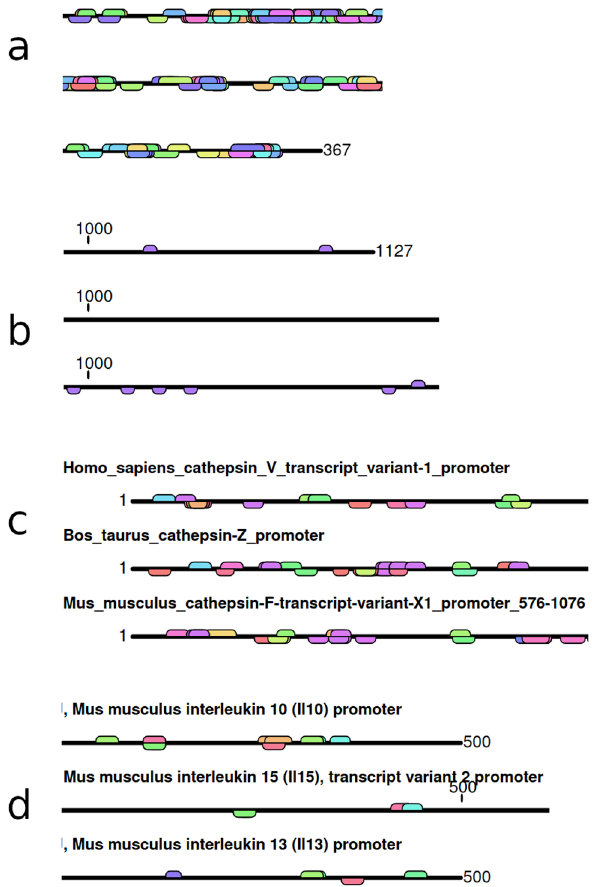
Figure 1. Transcription factor binding and module searches using AIModules. Subfigures ( a – d ) are only excerpts; for full results visit https:// bioin fo- wuerz. de/ aimod ules/; the black line represents the sequence itself. Above the line you will find the motifs of the (+) strand and below the line are the motifs from the (−) strand. The results can be downloaded from the web application as an Excel file; the application is described in detail in the Supplementary Tutorial file; the sequences can be found in the Supplement Evaluation section “Used sequences”; ( a ) TFBS search for the promoters X73536.1_H.sapiens_promoter_region_of_human_IL-10_gene, AY486432.1_Macaca-mulatta_ interleukin-10-(IL-10)_gene_promoter_region and AF121965.1_Mus- musculus_interleukin-10-(IL10)_gene_promoter_partial_sequence (configuration: La 6, Ld 8, vertebrates matrices from JASPAR DB) (excerpt contains base pairs 250–400; results can be found in the file Supplements. zip); ( b ) Poly adenylation site motif search for the promoters NM_000600.5 Homo sapiens interleukin 6 (IL6)-transcript variant 1, NM_000594.4 Homo sapiens tumor necrosis factor (TNF) and NM_020525.5 Homo sapiens interleukin 22 (configuration: La 9, Ld 8, own Poly-(A)-matrix) (excerpt contains base pairs 990–1150; results can also be found in the Supplement Evaluation section “Poly adenylation site motif results”); ( c ) Module search for promoters Homo_sapiens_cathepsin_V, Bos_taurus_cathepsin-Z and Mus_musculus_cathepsin-F (configuration: threshold 3, La 6, Ld 8, vertebrates matrices from JASPAR DB) (excerpt contains base pairs 1–200; results can also be found in the file Supplements.zip); ( d ) Module search for promoters Mus musculus interleukin 10, Mus musculus interleukin 15 and Mus musculus interleukin 13 (configuration: threshold 3, La 8, Ld 8, vertebrates matrices from JASPAR DB) (excerpt contains base pairs 300-550; NFAT for all sequences was found as previously described in 35 ; results can also be found in the Supplement Evaluation Table